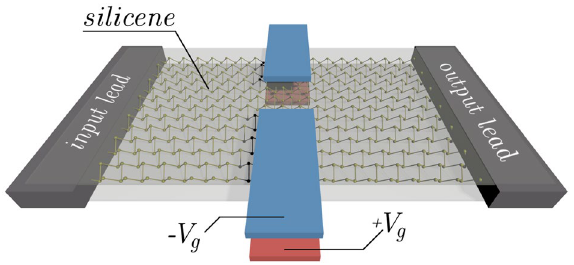
Figure 1. Schematic view of the system. A silicene nanoribbon is sandwiched between dielectric layers. Two pairs of external gates provides electric potential V g equalizing the effective energy on both sublattices.